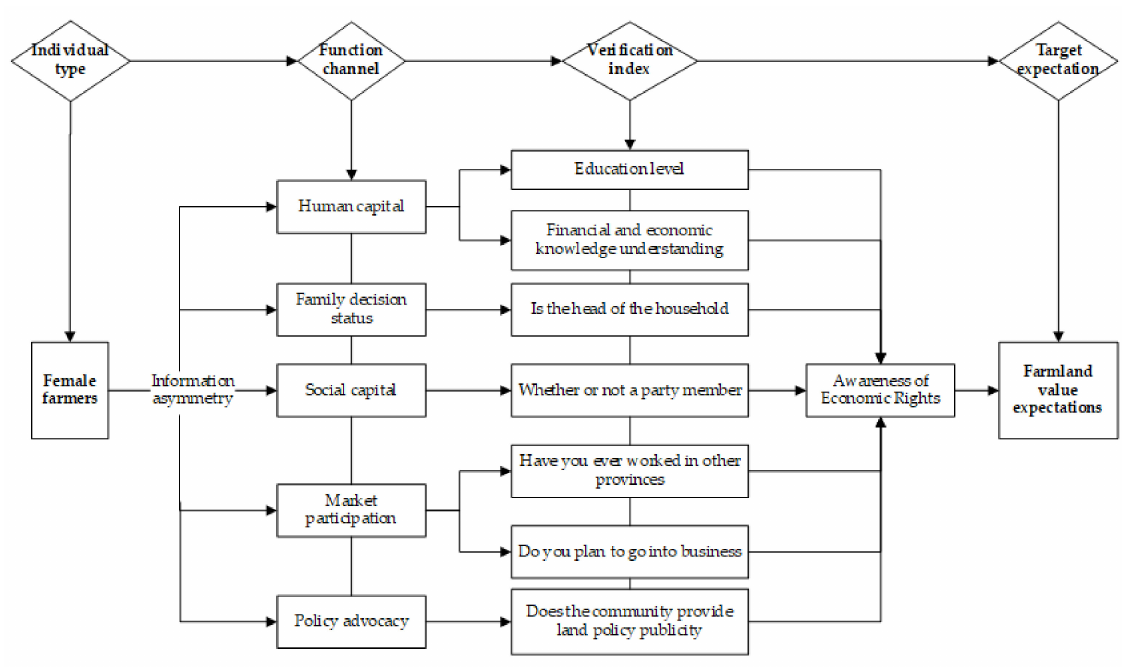
Figure 2. Theoretical analysis framework and verification